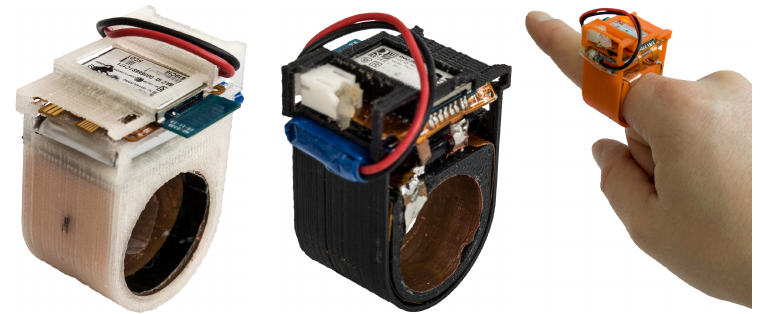
Figure 1. PeriSense prototypes in different colors and